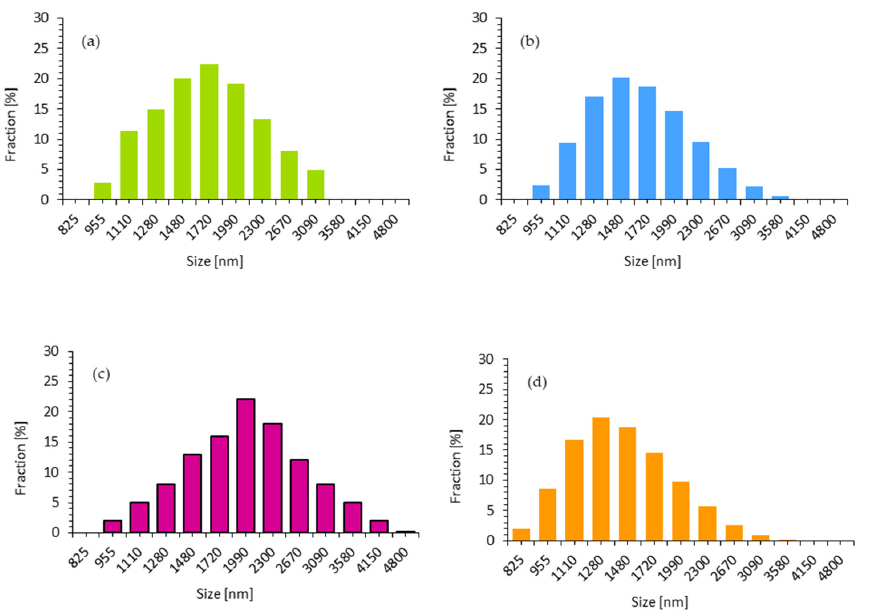
Figure 2. Particle size distribution of ( a ) WS ( b ) WS/P, ( c ) WS/MMT, and ( d ) WS/HL.